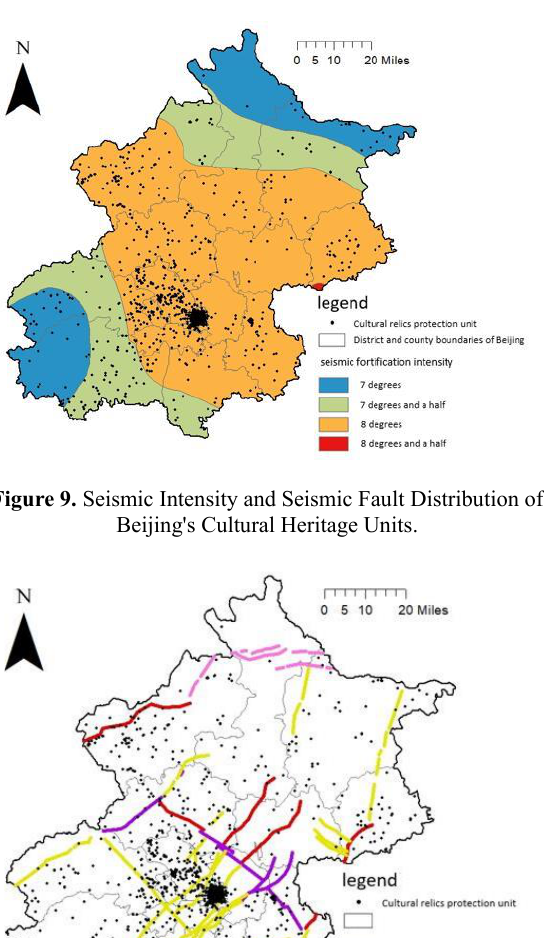
Figure 11. Number of cultural preservation units within the 500m buffer zone of seismic faults in